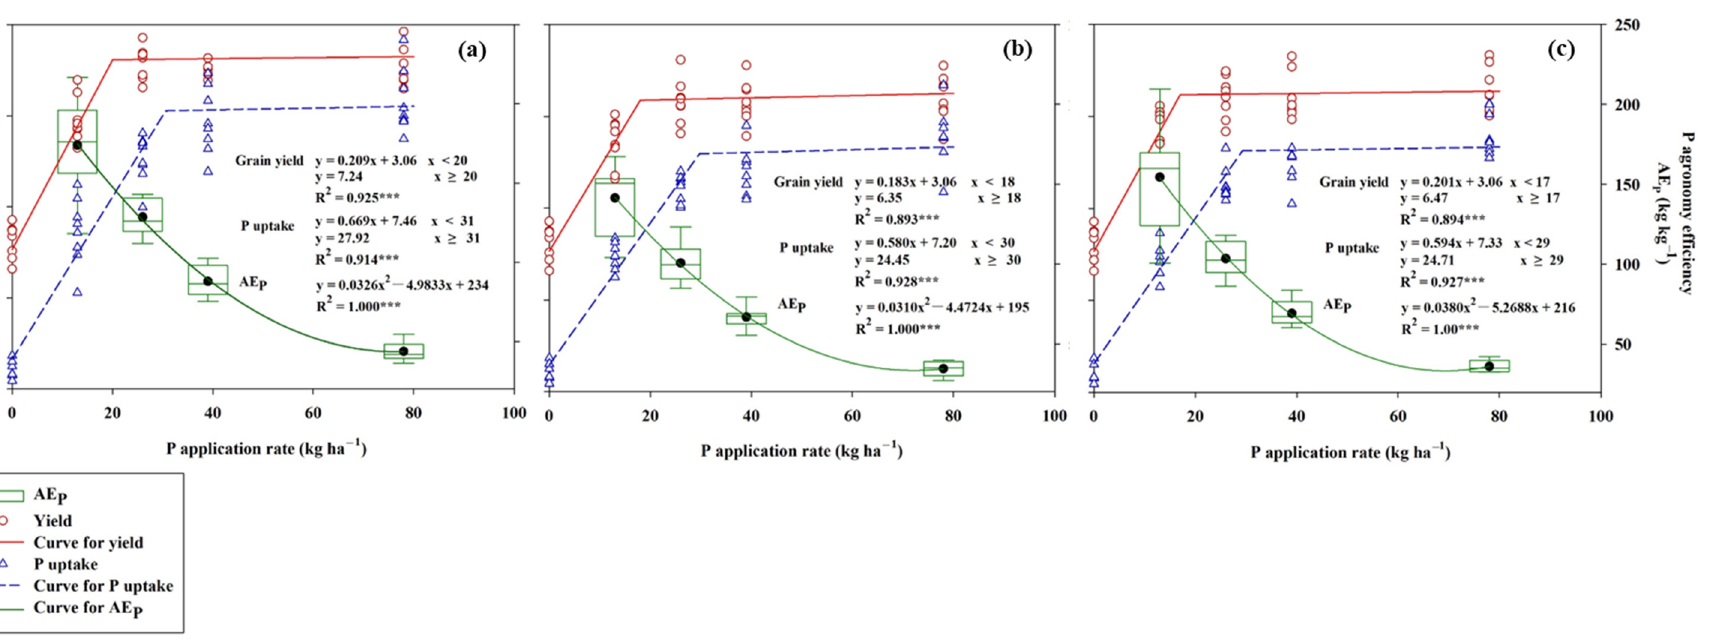
Figure 1. The response function of wheat yield, aboveground P uptake and P agronomy efficiency (AE P ) to different P application rates under superphosphate ( a ), monoammonium phosphate ( b ), and ammonium polyphosphate ( c ) in 2018 and 2019. Box-whisker diagrams showing the average, 25th, 50th, and 75th percentiles of AE P . *** significant at p < 0.001.